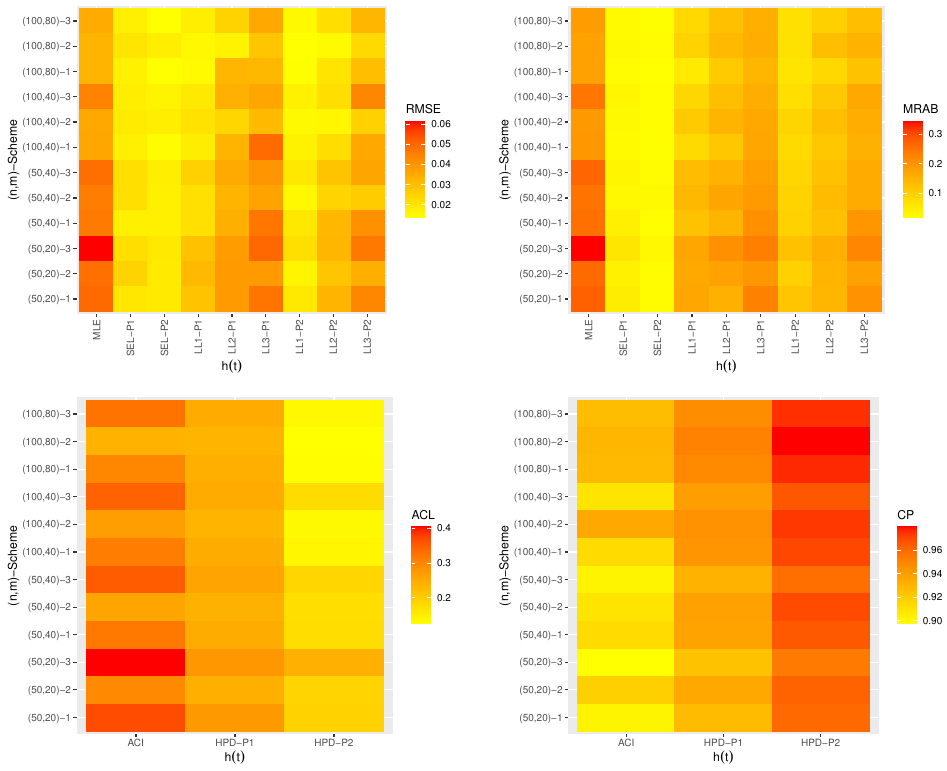
Figure 7. The heatmaps for estimation results of h ( t ) .